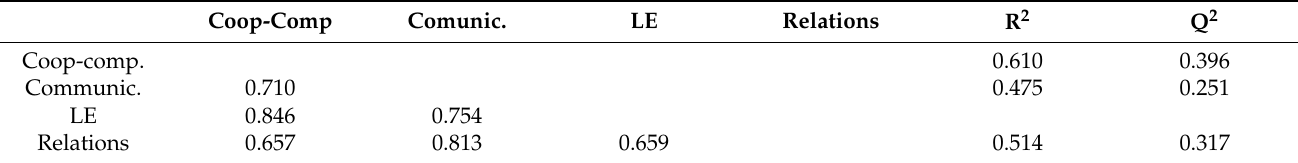
Table 3. Discriminant validity matrix (HTMT), R 2 y Q 2